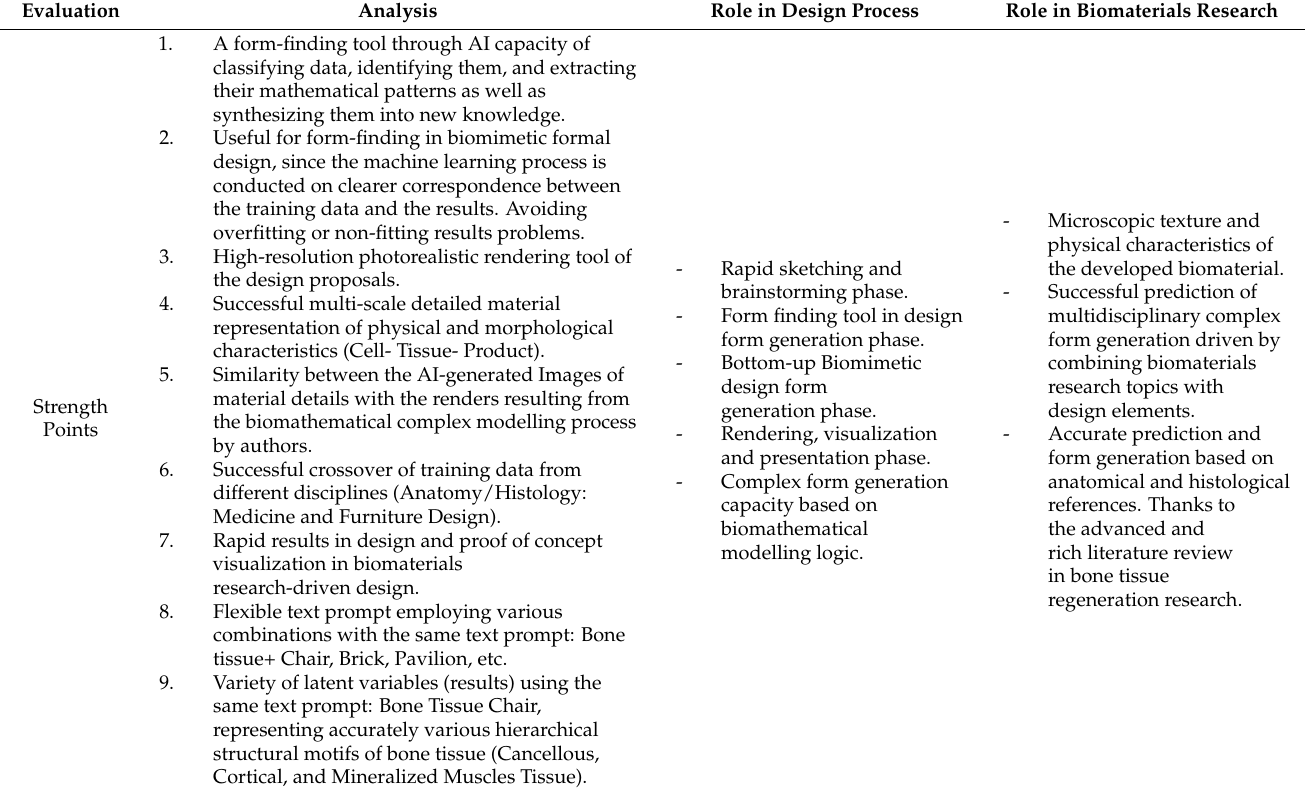
Table 1. The bone chair biomineralization research project: SWOT analysis of integrating AI text-to- image model Midjourney in the biomaterials research-driven design